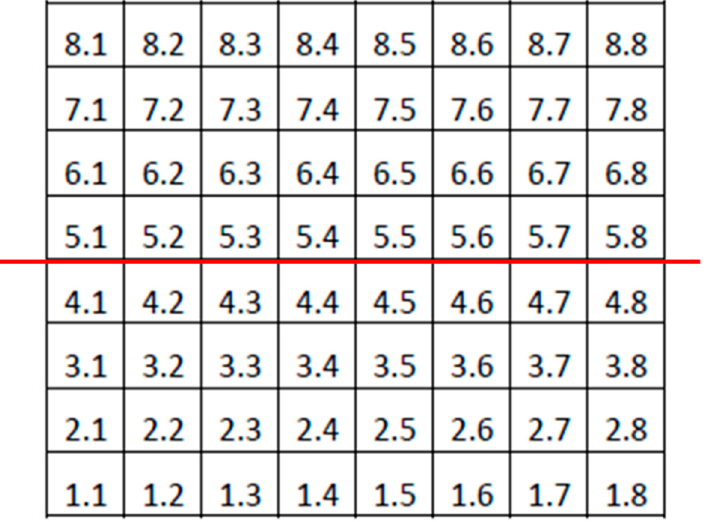
Figure 2. Automatic segmentation of the di ff erent retinal layers in macular area.